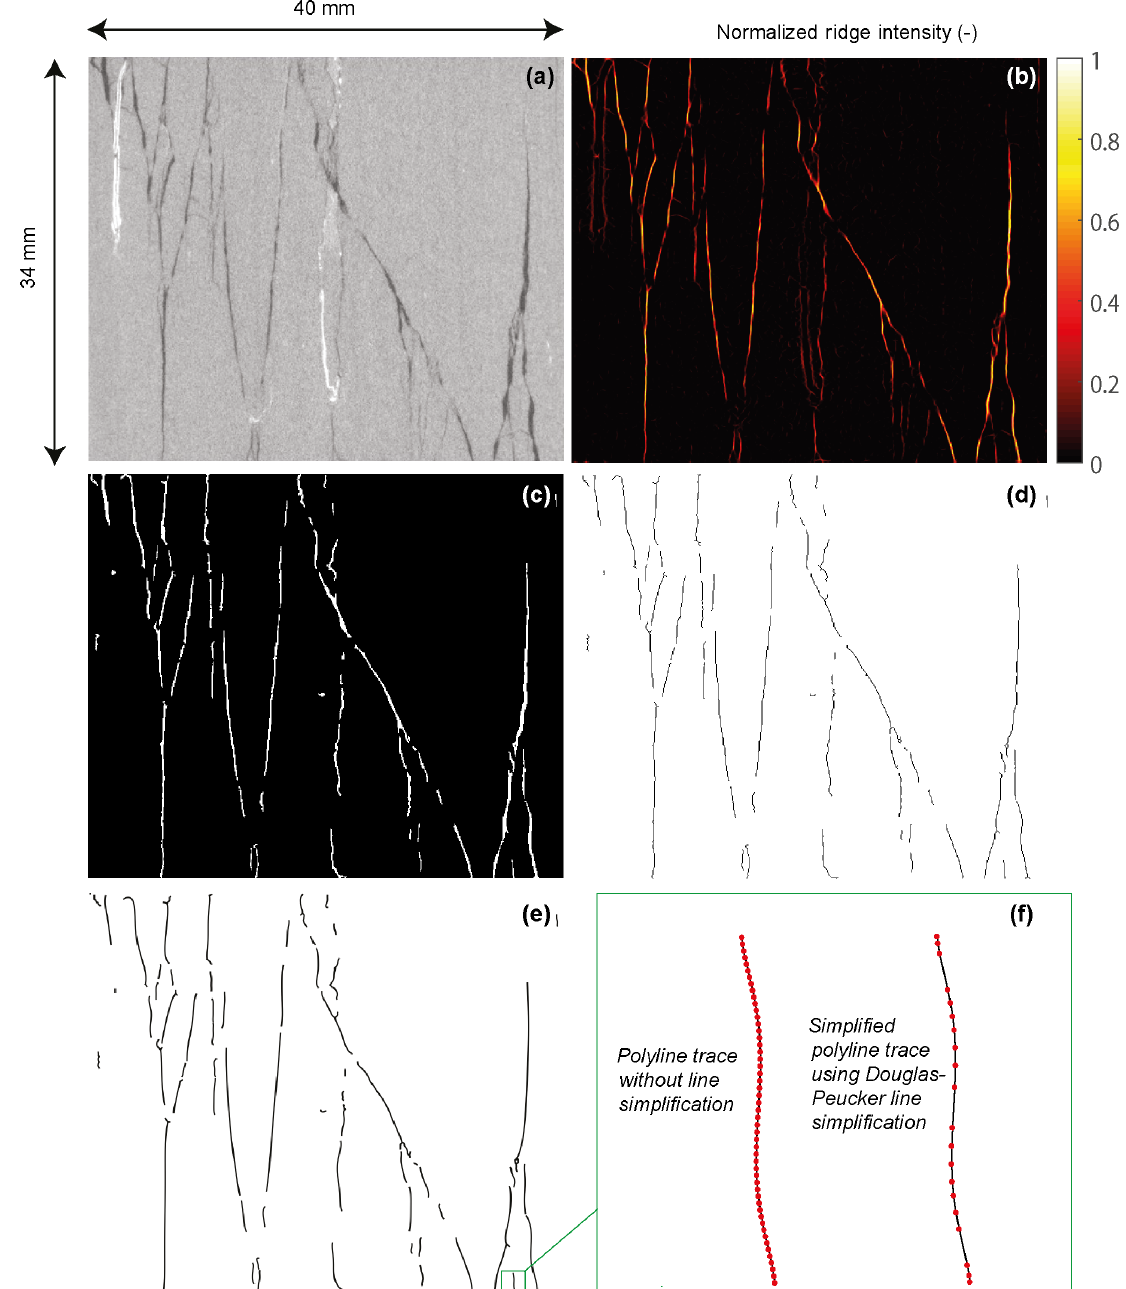
Figure 2. Illustration of the steps involved in the automatic fracture extraction using a 40 × 34mm fractured shale core image. (a) CT scan core image from Dwarkasing (2016). (b) Normalized ridge ensemble. (c) Segmentation applied to the ridge ensemble. (d) Skeletonization applied to the segmented ridge. (e) Vectorized polylines fitted to the skeletonized clusters. (f) Effect of line simplification applied to a single vectorized